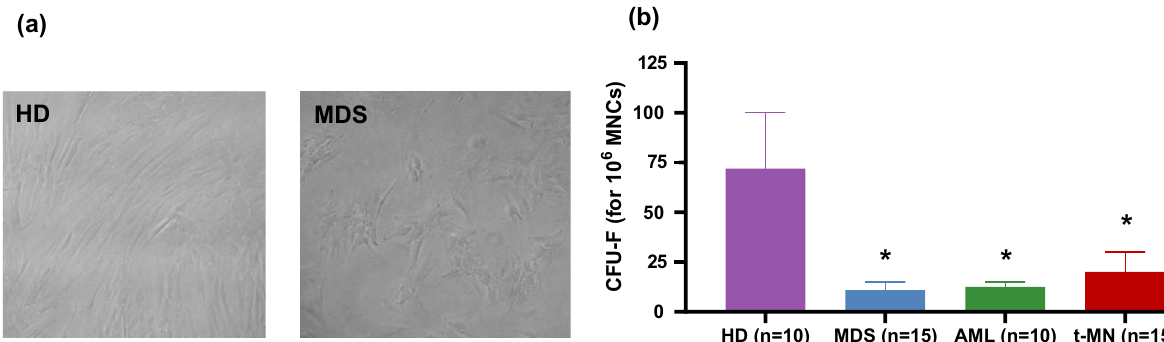
Figure 1. Phenotype and growth properties of patients and HD-derived MSCs. ( A ) Representative pictures of MSCs morphology in MDS patient and HD. ( B ) The Bar charts show CFU-F normalized to 1 × 106 seeded BM-MNCs (HD n = 10; AML n = 10; MDS n = 15; t-MN n = 15). Mean values are indicated by bars, while error bars indicate standard deviation. The Mann Whitney test was used to detect statistically significant differences between controls and each patient group. * p <